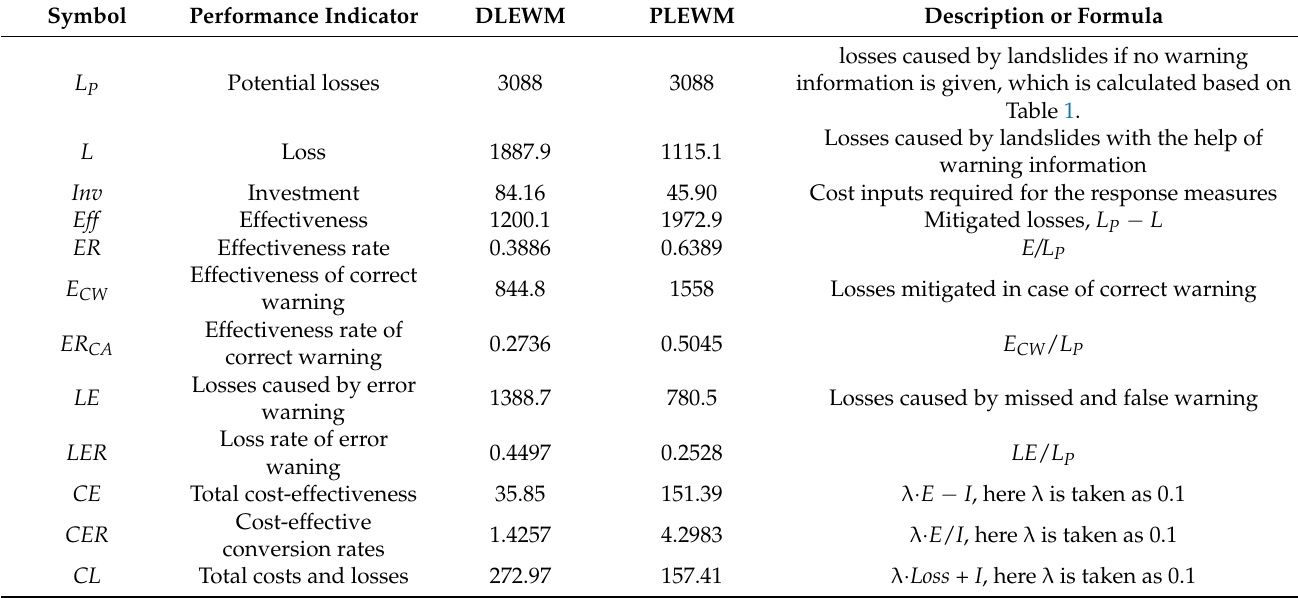
Table 4. Economic indicators system for evaluating the performance of multi-level warning models.